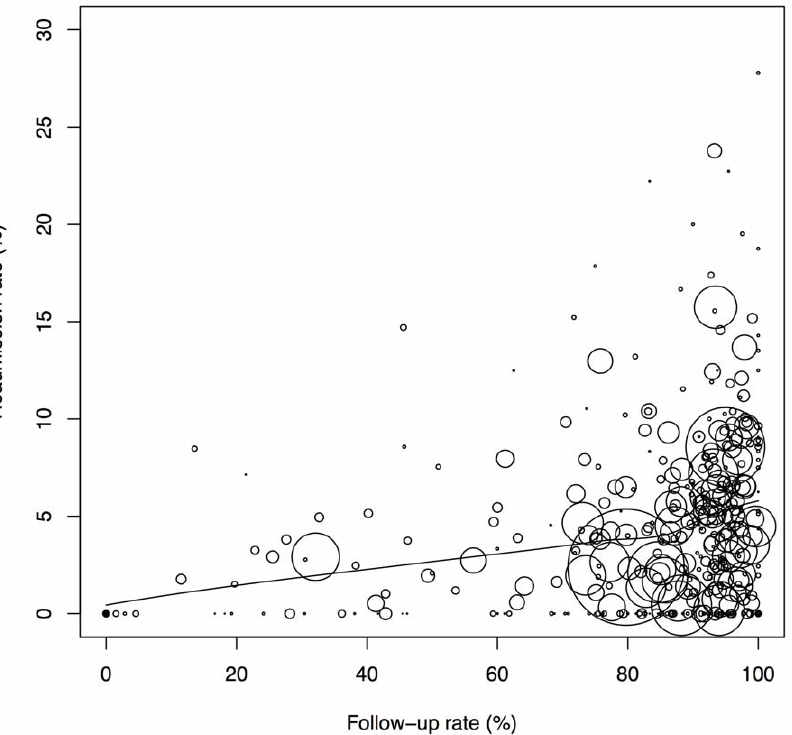
Figure 3. Loess plot of RYGB readmission rates on follow-up rates. Circles represent BSCOE hospitals with the size weighted by the number of patients who underwent the procedure in the hospital during the study period. doi:10.1371/journal.pone.0032506.g003 PLoS ONE |